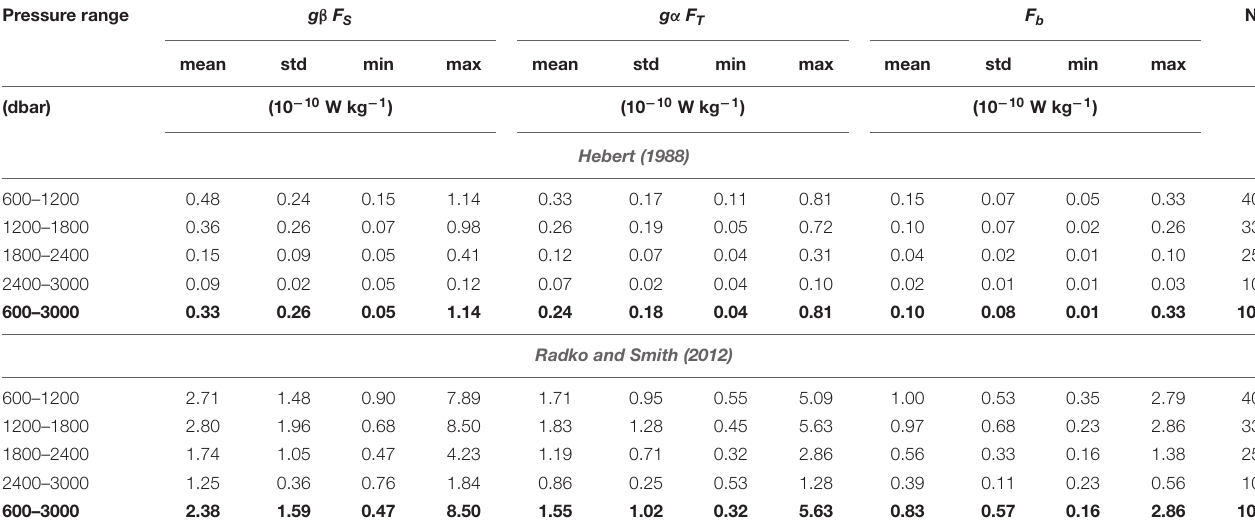
TABLE 1 | Some basic statistics (mean, standard deviation, minimum, and maximum) summarizing the fluxes calculated in different pressure ranges with the two models, H88 and RS12. Pressure